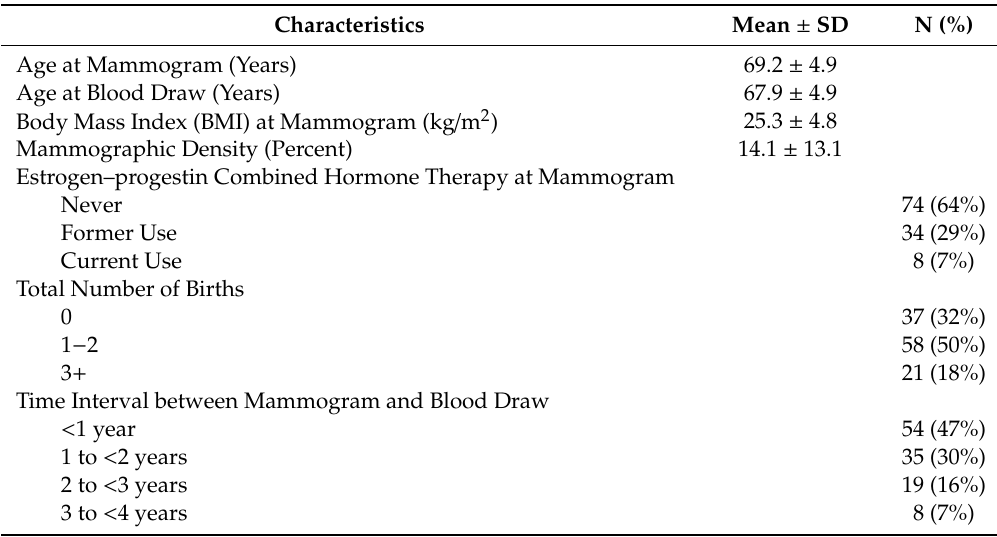
Table 1. Characteristics of 116 postmenopausal non-Hispanic white participants included in this